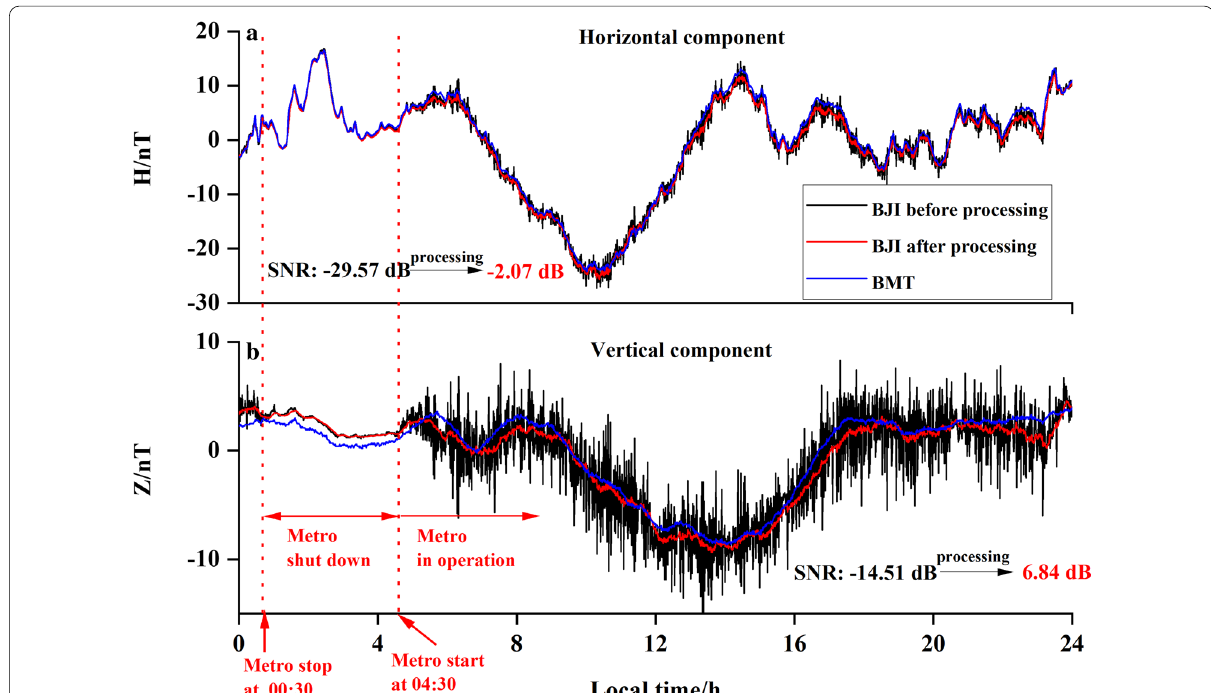
Fig. 1 Geomagnetic data collected at BJI (black line), the processed data with the adaptive Kalman filter (red line) and data at BMT (blue line). a Horizontal component. b Vertical component. The mean values were subtracted to keep the geomagnetic data on the same order of magnitude. The vertical geomagnetic field at BJI are largely affected by the Metro